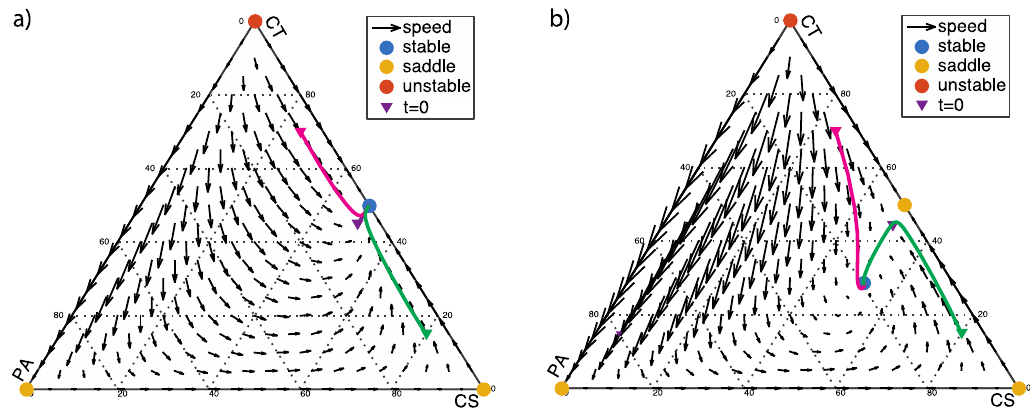
Figure 1. α > 0 and β > 0: ( a ) α < β + 1, α = 0.5, β = 0.2; ( b ) α > β + 1, α = 1.5, β = 0.2. The initial population fractions of commensal antibiotic-sensitive bacteria (CS), commensal antibiotic-tolerant bacteria (CT), and pathogenic (PA) cells (x 10 , x 20 , x 30 ) = (0.5, 0.545, 0.05), (0.25, 0.7, 0.05), and (0.8, 0.15, 0.05) are labeled with triangle markers.